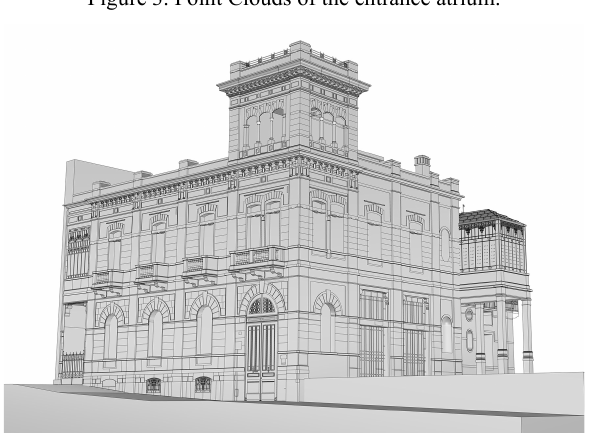
Figure 3. Point Clouds of the entrance atrium.